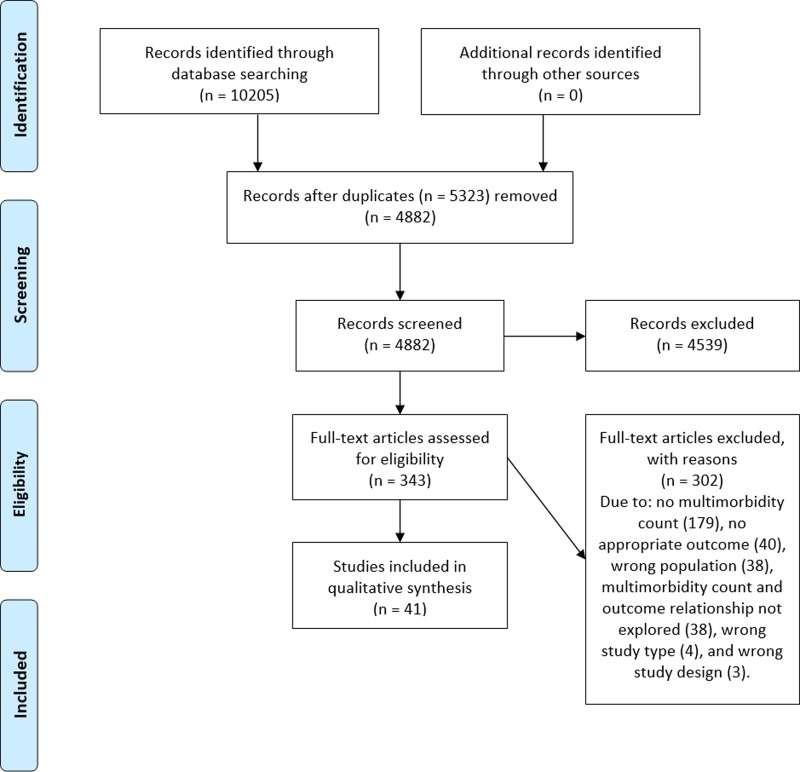
PRISMA flow diagram.